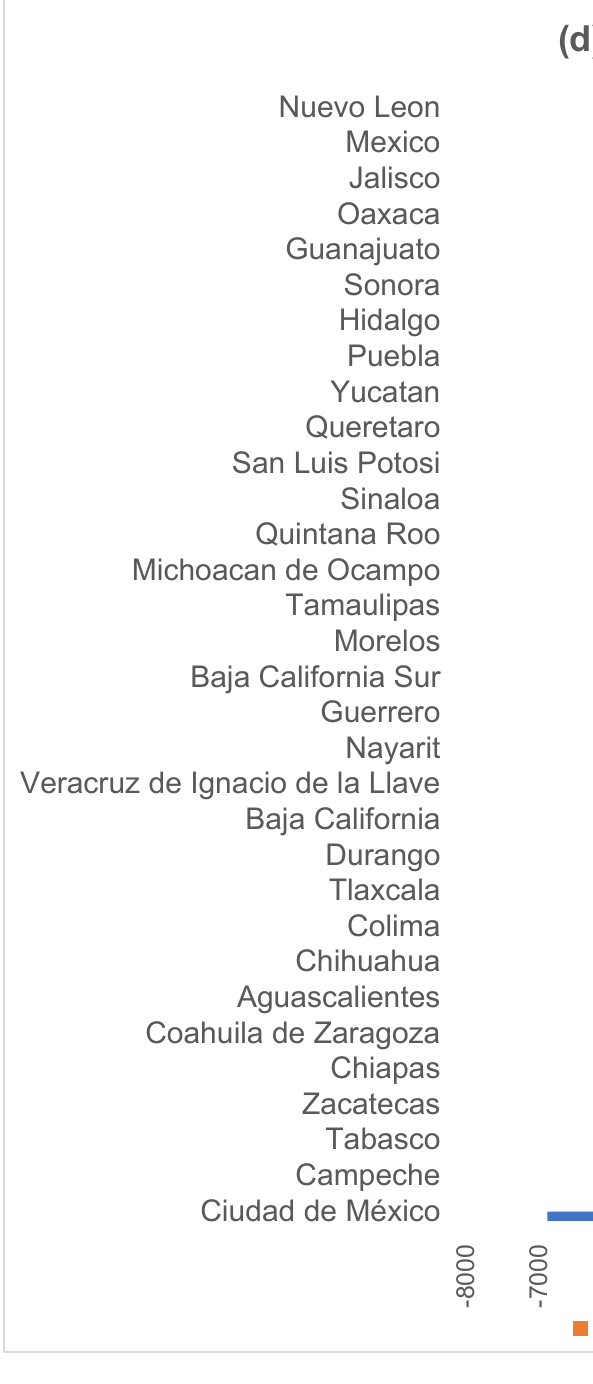
Figure 4. Net balances of VA and CO2 in trade. Note: The graphs of the four analyzed countries are presented, with the regional aggregation adopted in the study. The first refers to the Brazilian states, the second to the Chilean regions, the third to the Colombian departments, and the fourth to the Mexican states.